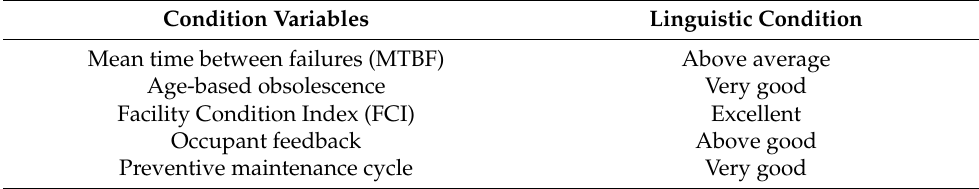
Table 6. Linguistic conditions for condition